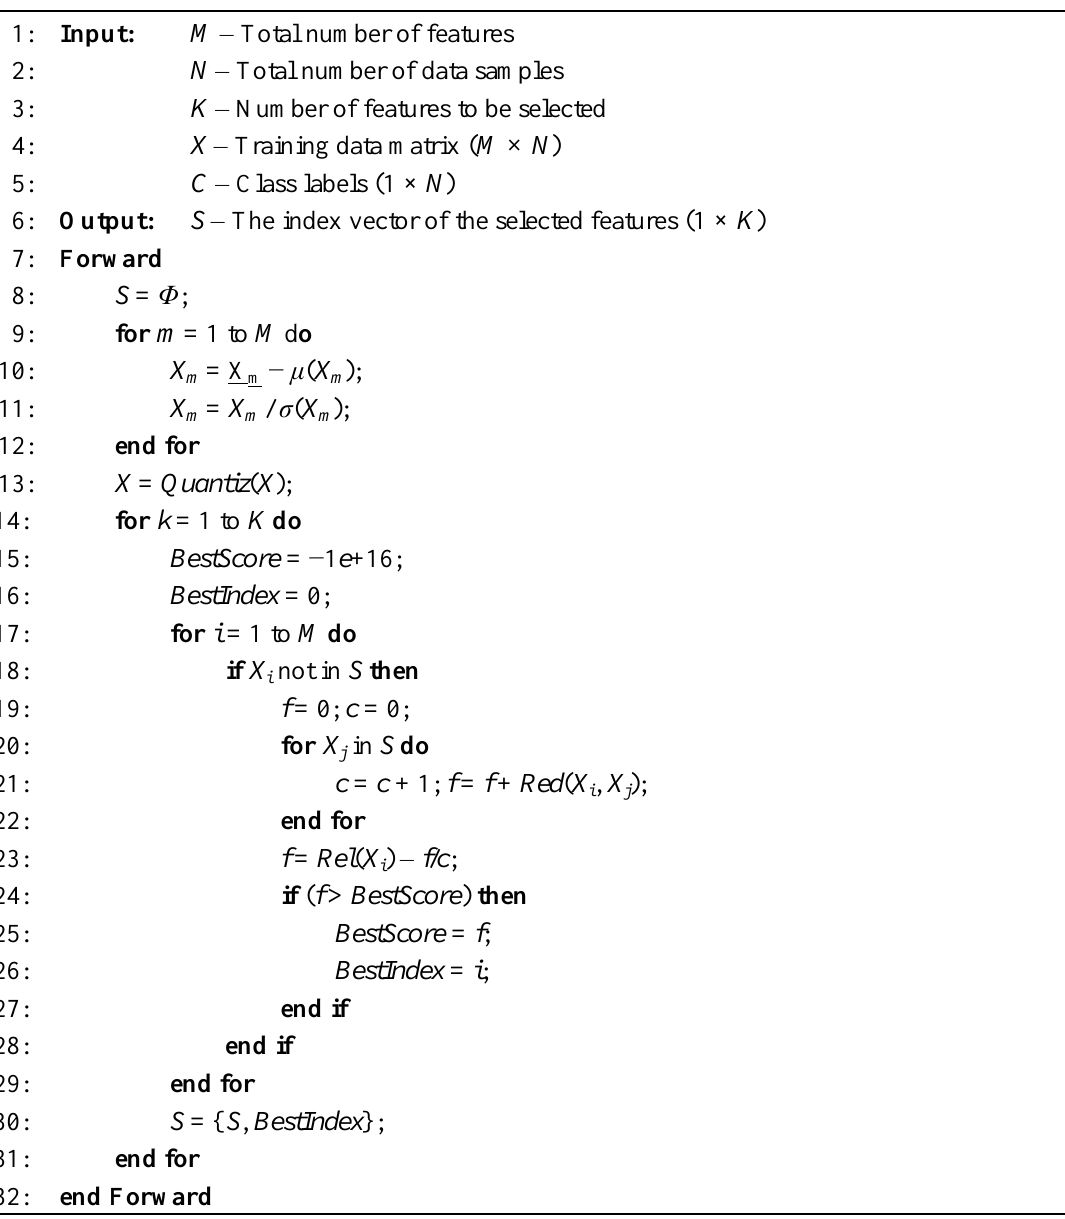
Algorithm 2. Greedy Forward Searching for Feature